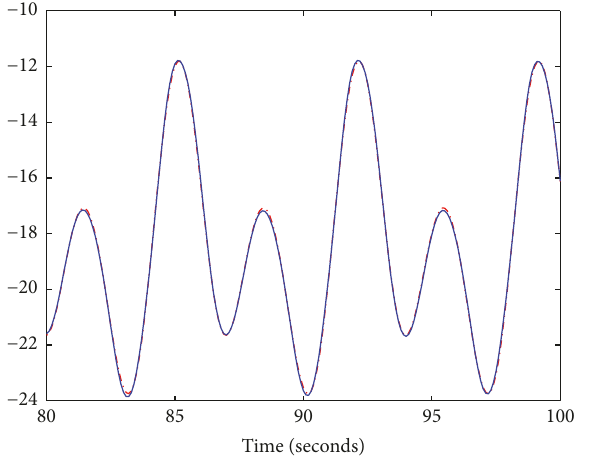
Figure 10: Function approximation: Φ 2 (𝑍) (—) and 𝑊